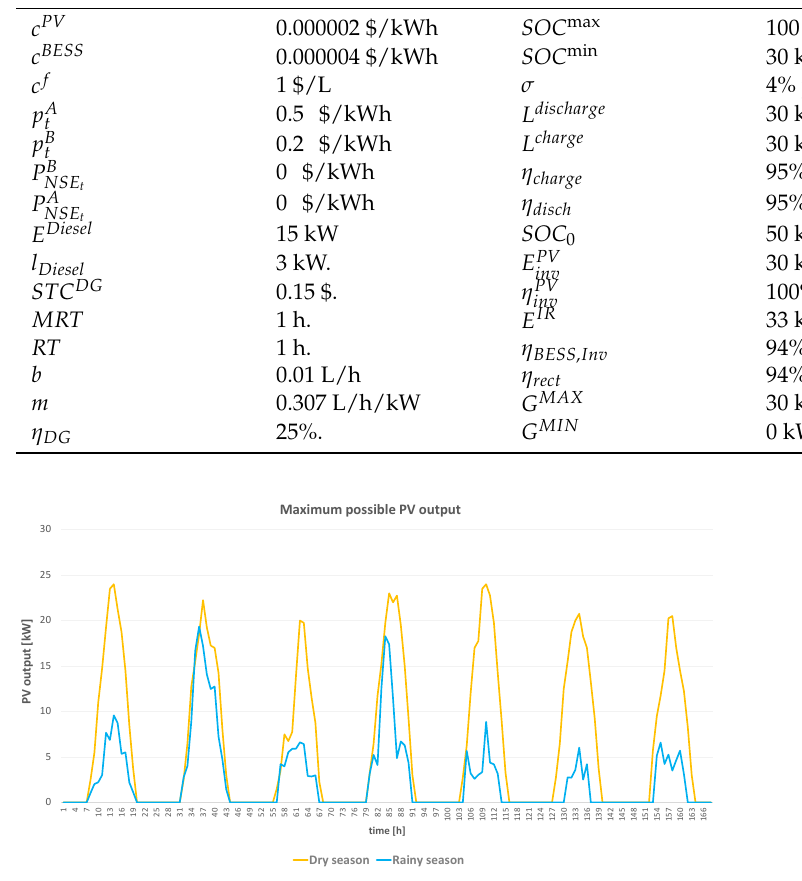
Figure A1. Maximum PV output for a rainy and a dry season week for Section 5.